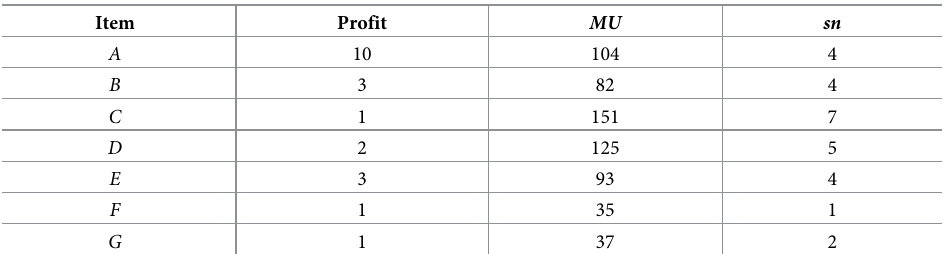
Table 2. Profit table.